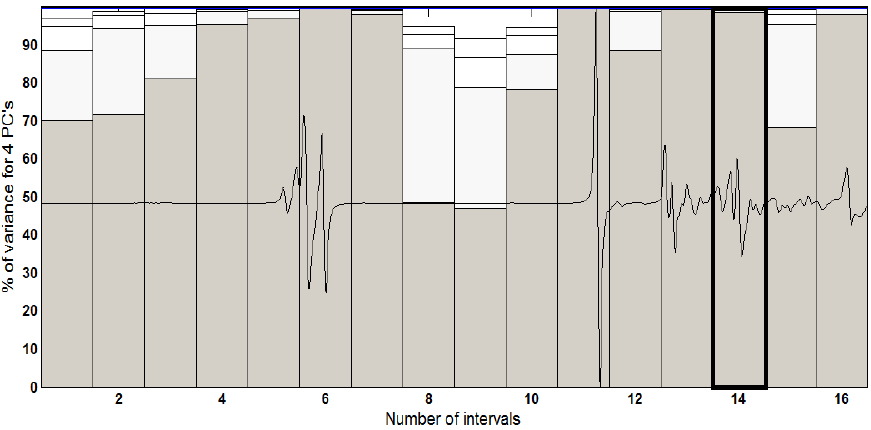
Figure 5. Percent variance to the UATR-FTIR derivate spectra data divided into 16 equidistant intervals.